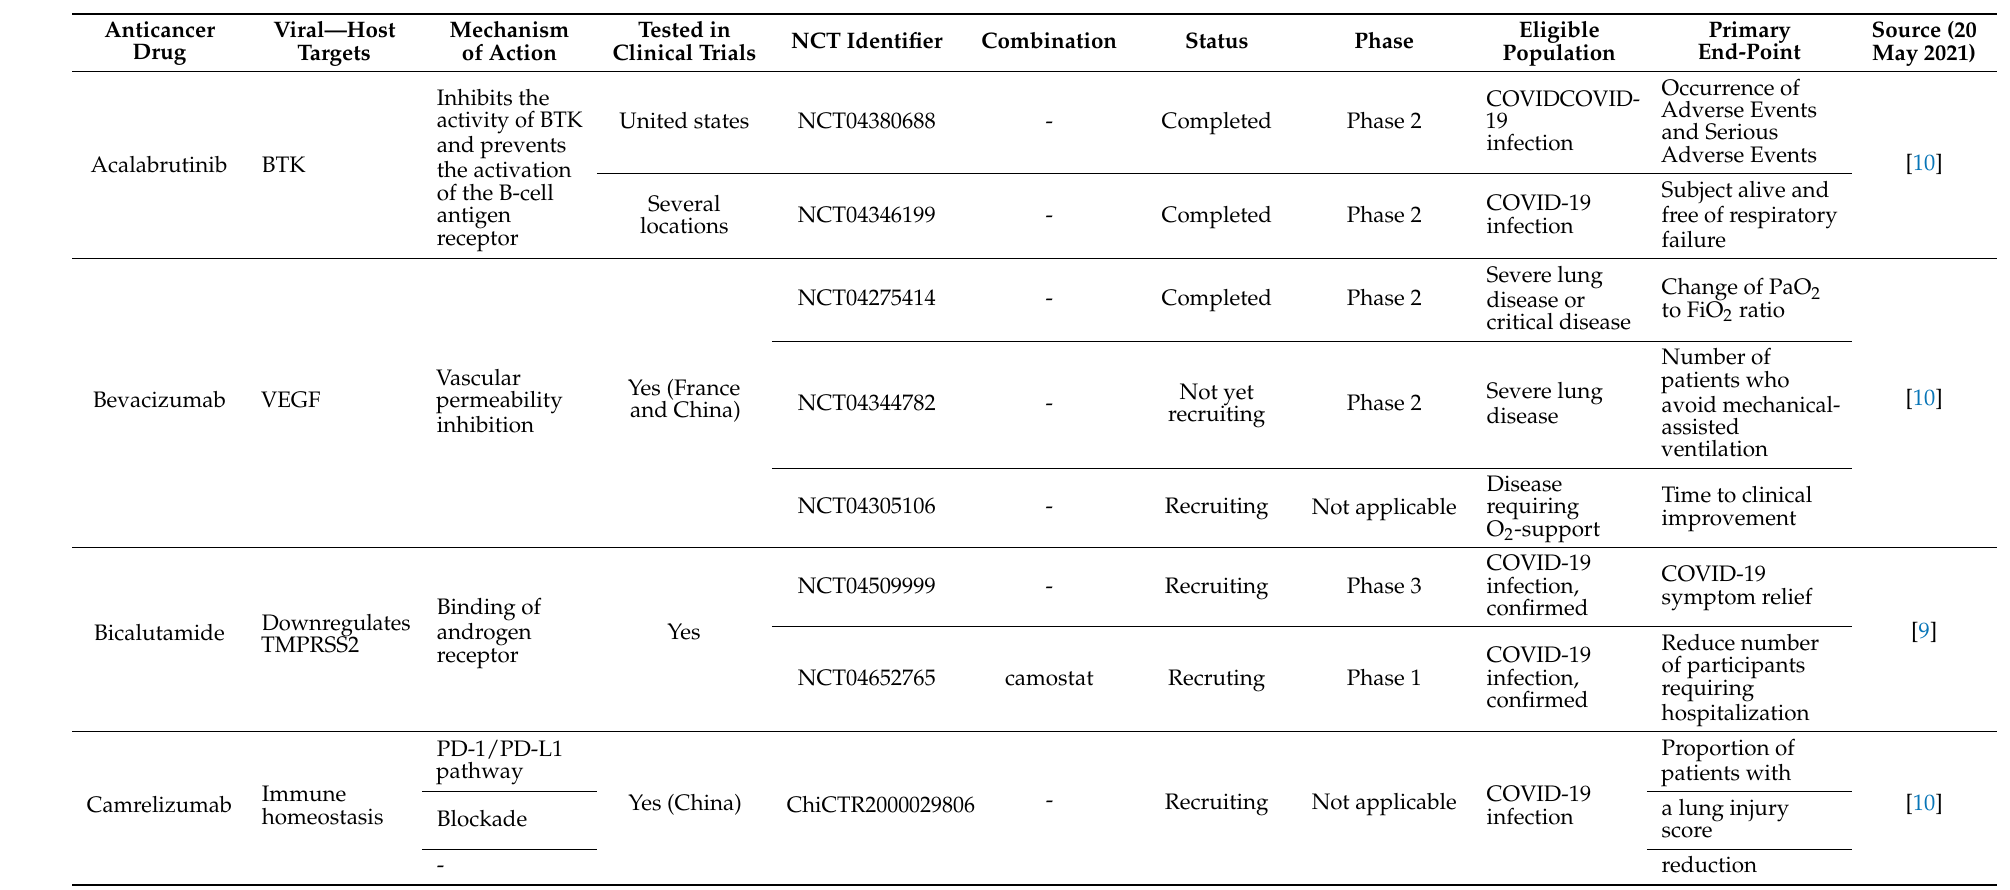
Table A1. List of drugs with anticancer effects or used for best supportive cancer care, in clinical studies for the treatment of